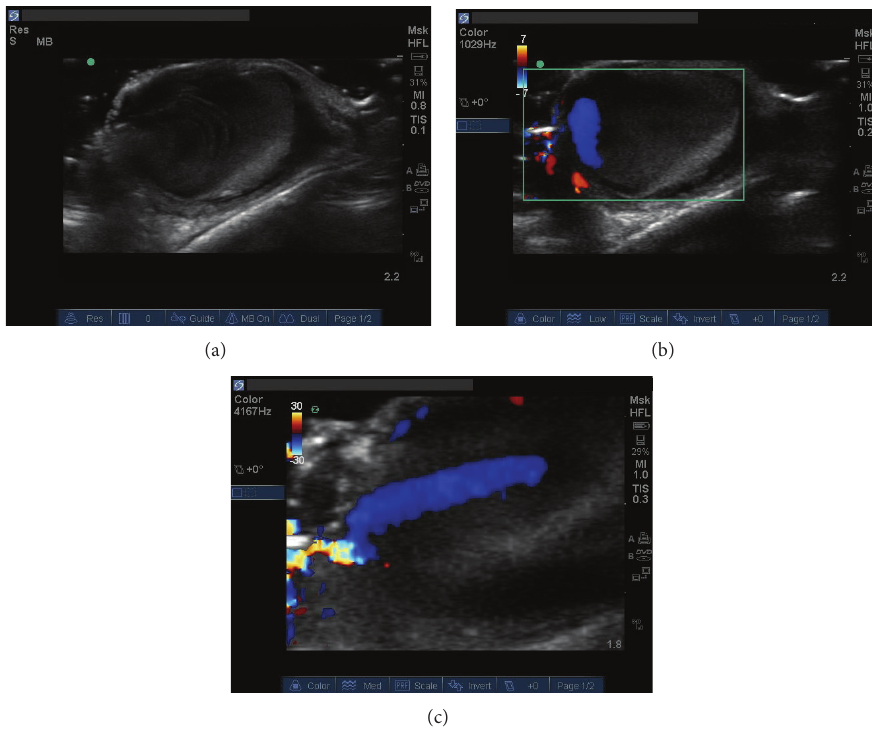
Figure 1: Ultrasound images of patient’s pseudoaneurysm. (a) B-mode ultrasonography shows a fluctuant mass with internal echoes similar to an abscess. Dynamic images would reveal wave-like flow through the mass suggestive of communication with a vessel lumen. (b) Color Doppler ultrasonography confirms vascular communication and pulsatile flow. (c) Color Doppler ultrasonography zoomed in on the pseudoaneurysm neck further confirms communication of pseudoaneurysm with an arterial lumen (see Supplementary material which is available online at